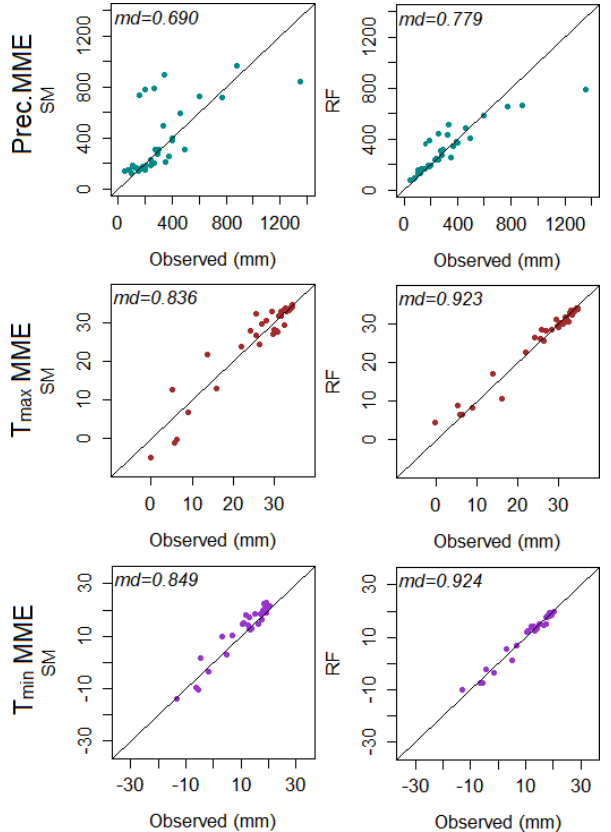
Figure 7. Scatter of spatially averaged annual P , T max and T min of MMEs developed with simple mean (SM) and random forest (RF) using four top-ranked GCMs plotted against GPCC P , CRU T max , and CRU T min for the period 1961 to